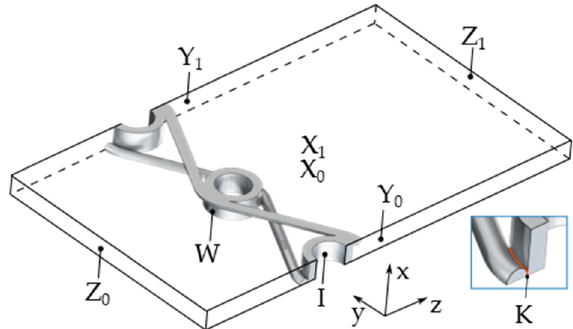
Figure 3. Illustration of the computational domain and domain boundaries used for the Computational Fluid Dynamics (CFD) analysis of a periodic / symmetric section of the heat exchanger. The contact surface between tube and wire with thermal resistance K is